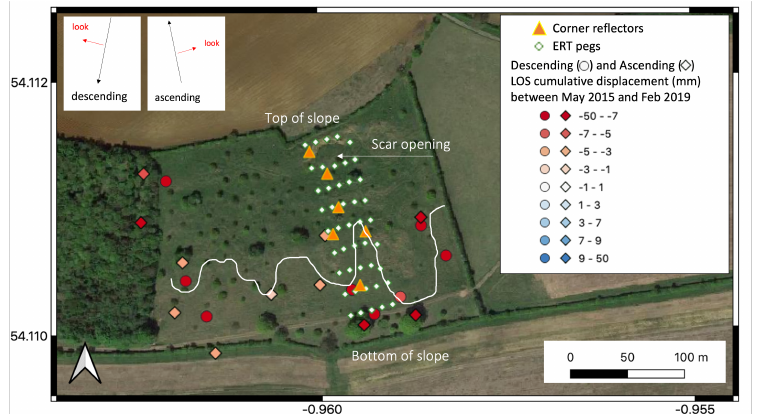
Figure 2. Overview of the Hollin Hill Landslide Observatory. The orange triangles show the locations of the 6 corner reflectors installed in July 2019. The white diamonds show the location of the pegs of the Electrical Resistivity Tomography (ERT) and where GNSS measurements are carried out periodically. The locations shown in this figure are the latest in 2019 before new pegs were installed. Pixels of descending (circles) and ascending (diamonds) InSAR measurements are marked and their colour shows the velocity of that point between May 2015 and February 2019 with reference to a nearby stable area. Both ascending and descending measurements are referenced to the same area. The white line marks the extent of the flow